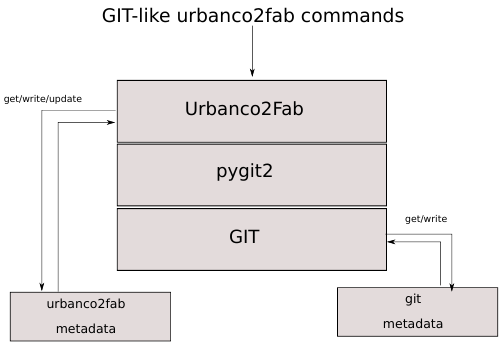
Figure 7. UrbanCo2Fab built over GIT using